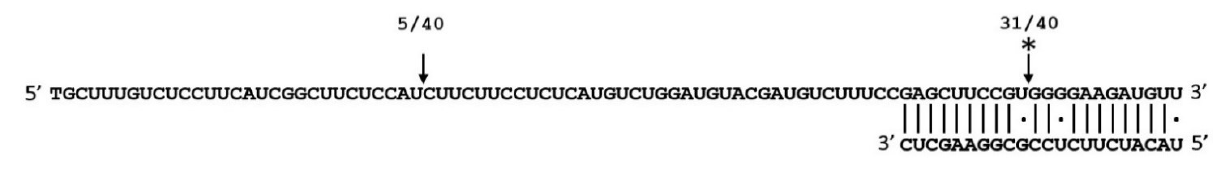
Figure 7. 5′ RACE analysis revealing the cleavage site in regions targeted by miR1885b in the roots of infected CR Shinki plants. The miR1885b and Bra019412 sequences are aligned and the predicted cleavage site is indicated with an arrow and an asterisk. The numbers above the sequence indicate the identified cleavage site in independent clones.